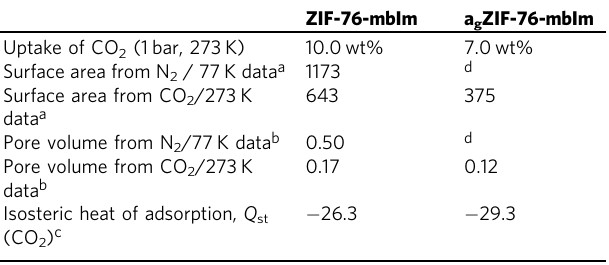
Table 2 Summary of the textural characteristics of a permanent porous glass derived from